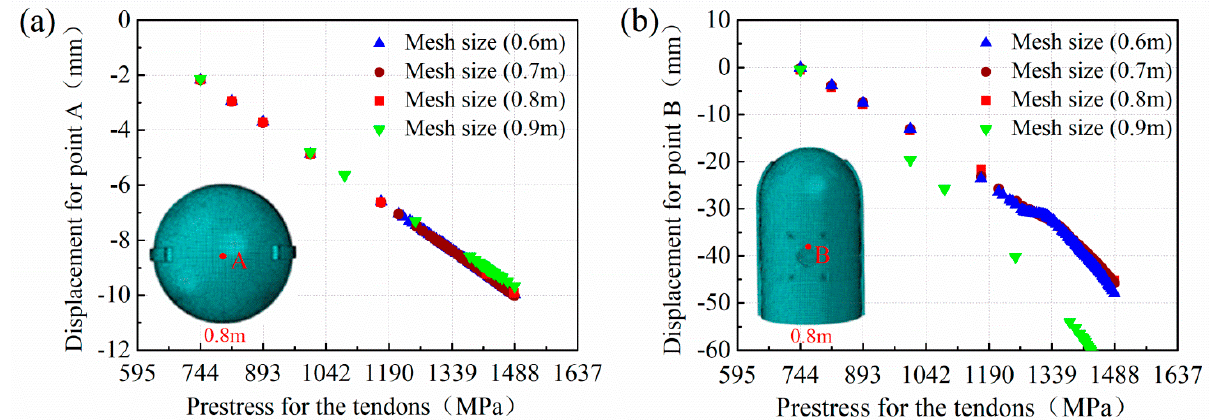
Figure 3. Mesh sensitivity analysis: point A ( a ); point B ( b ).